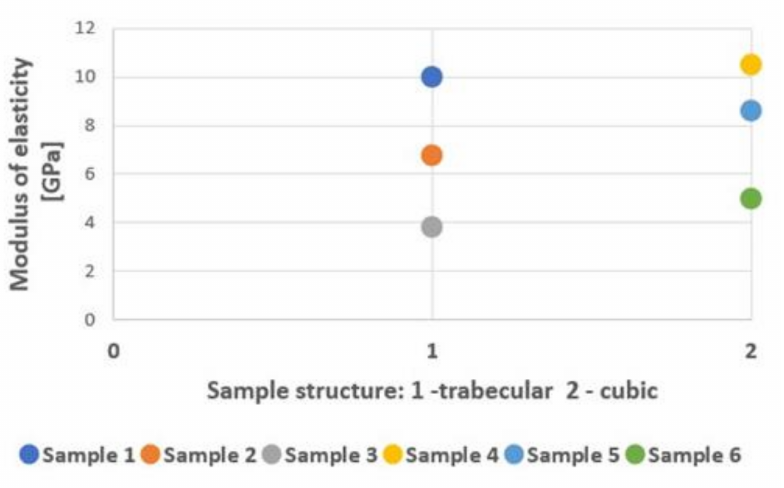
Figure 17. Comparison of the modulus of elasticity considering both types of sample